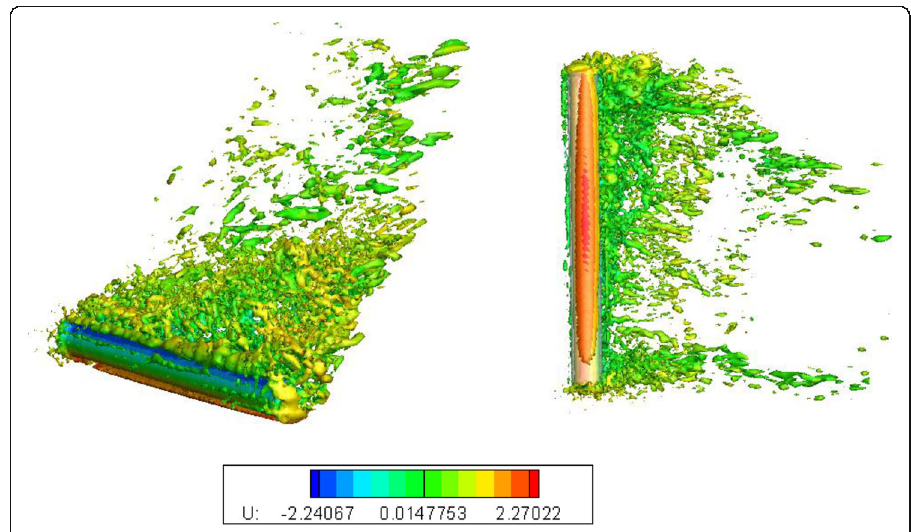
Fig. 8 Instantaneous Q criterion ( Q = 1000) for Magnus rotor with AR = 10. Isosurface is colored by the normalized streamwise velocity ( U / U ∞